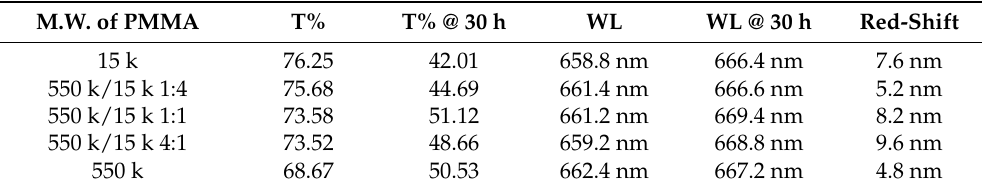
Figure 6. Spectral changes of red emissive composite films (5 wt% CuInS 2 NCs) prepared by blending PMMA with molecular weights of 550 k and 15 k. ( a ) The transmittance spectra before and after heating at 80 ◦ C; ( b ) The fluorescence emission spectra before and after heating at 80 ◦ C. Table 1. Transmittances and emission wavelengths of the composite films before and after heat treatment under vacuum drying